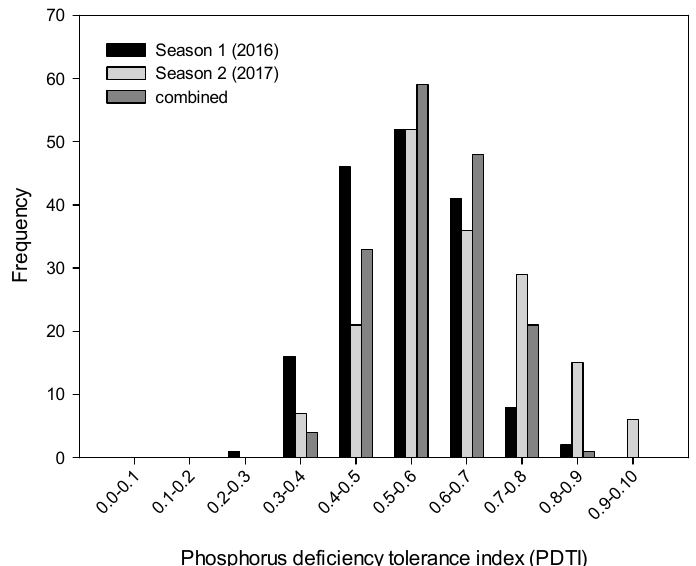
Figure 1. Frequency distribution of the phosphorus deficiency tolerance index (PDTI) of 168 Thai indigenous upland rice cultivars in Season 1, Season 2, and in combination. Based on the combined PDTI, the genotypes in our study were divided into 3 groups: Group 1, comprising 22 accessions showing high tolerance with PDTI values greater than 0.8; Group 2, comprising 107 accessions showing moderate tolerance with PDTI values between 0.6 and 0.8; and